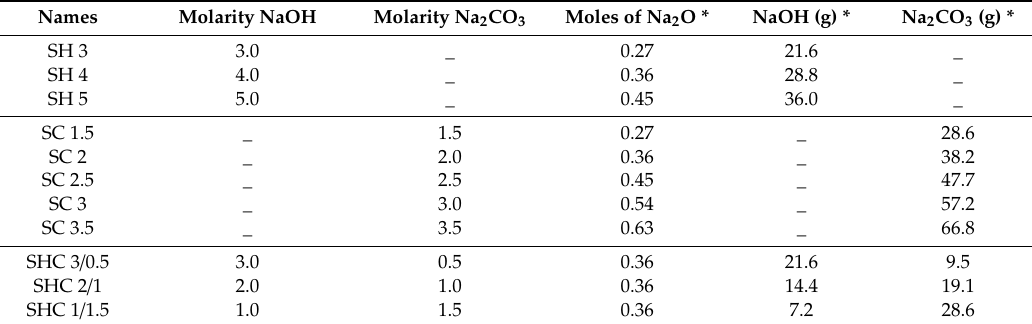
Table 2. Doses of alkali dissolutions for mortars.